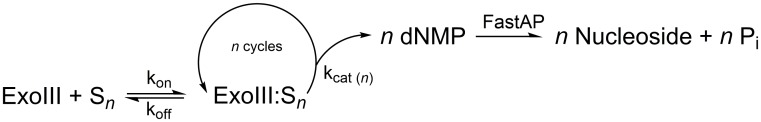
Kinetic model of Exonuclease III hydrolysis of a dsDNA substrate with n nucleotides susceptible to hydrolysis.